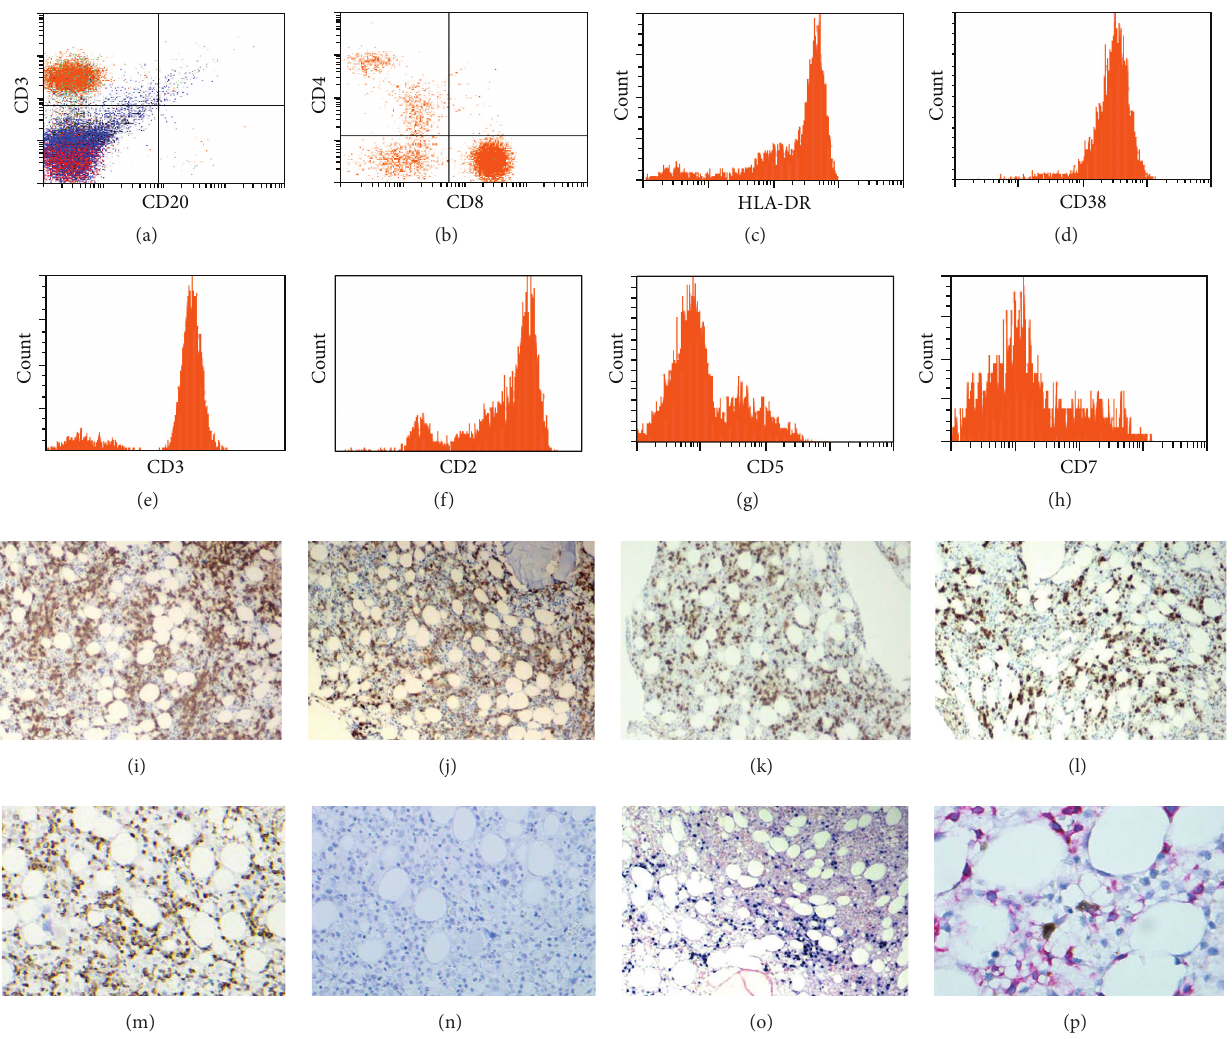
Figure 2: Immunophenotypic features of atypical lymphoid infiltrates. (a)–(h) Flow cytometry analysis of bone marrow showed most of lymphoid infiltrates were CD3+ (a and e), CD2+ (f), CD8+ (b) positive T cells with few CD4+ (b) T cells, and rare CD20+ (a) B cells. These T cells have bright HLA-DR (c) and CD38 (d) expression. Loss of CD5 (g) and CD7 (h) in T cells was evident. (i)–(n) Immunohistochemical stains of bone marrow showed a prominent CD3+ (i) and CD8+ (j) T cell infiltration. These T cells are positive for cytotoxic markers perforin (k), granzyme B (l), and TIA-1 (m) and negative for CD56 (n). (o) In situ hybridization of EBER showed diffuse EBER positive cells in the bone marrow biopsy. (p) Double immunohistochemical stains of CD3 (red) and EBV-LMP (brown) demonstrated colocalization of EBV and